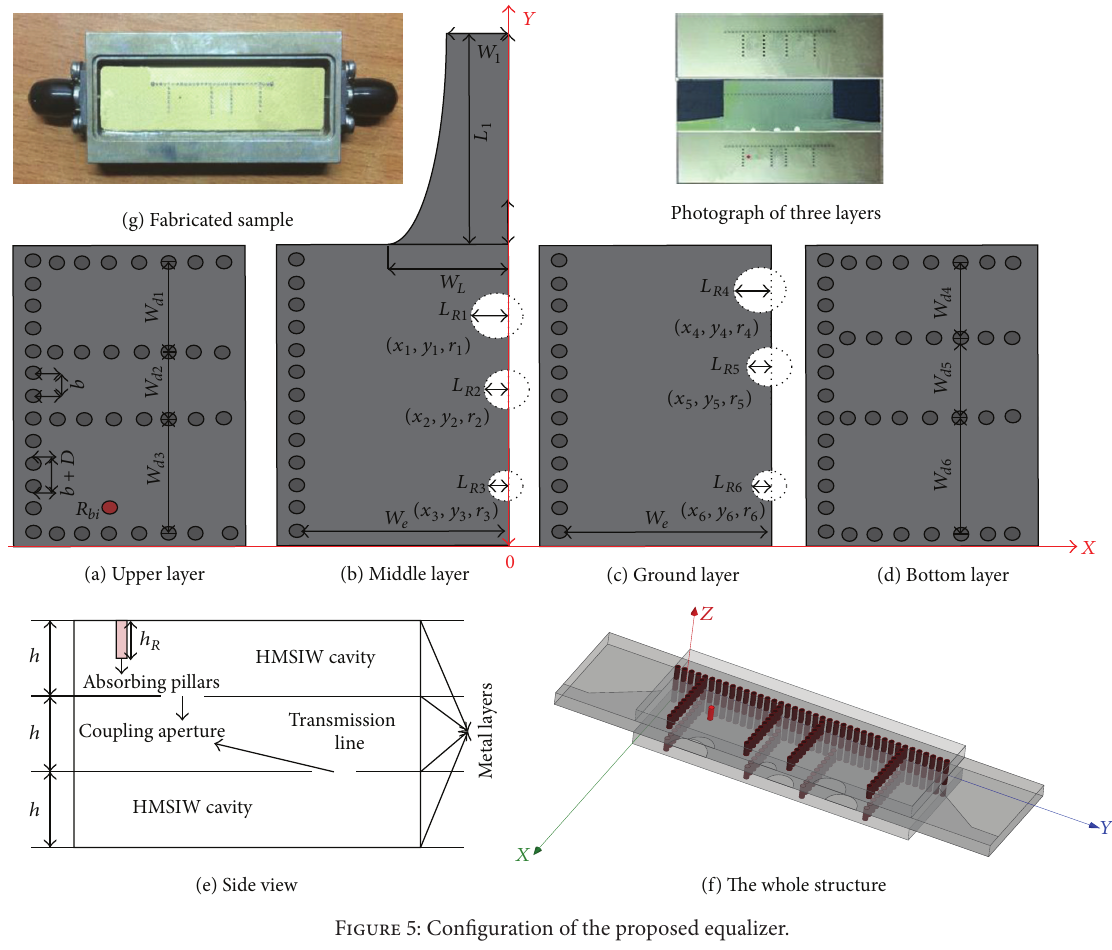
Figure 5: Configuration of the proposed equalizer.